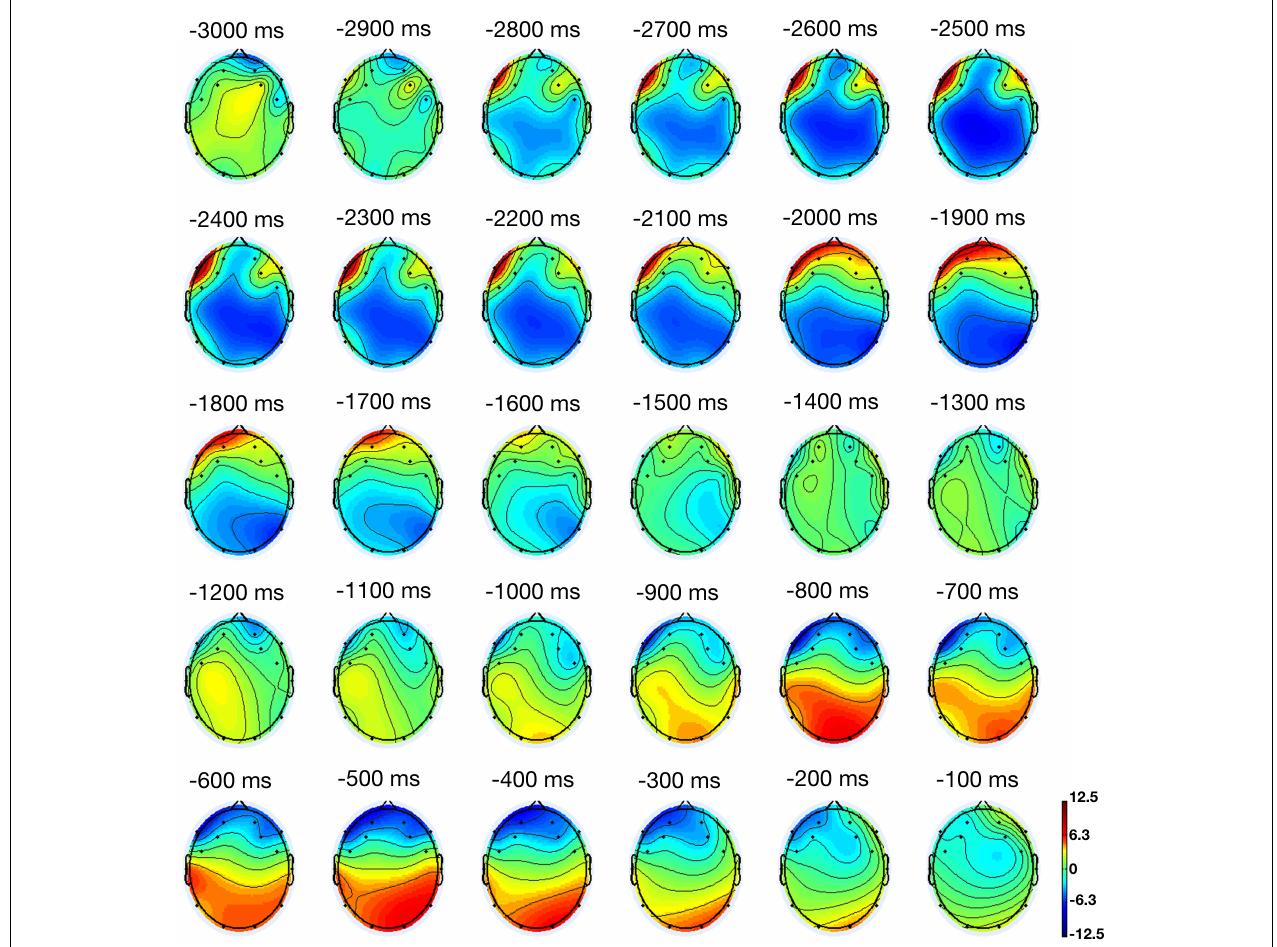
FIGURE 2 | Cortical activation throughout a trial. Presentation of the experimental stimulus (i.e., word pair) starts at − 2800ms.